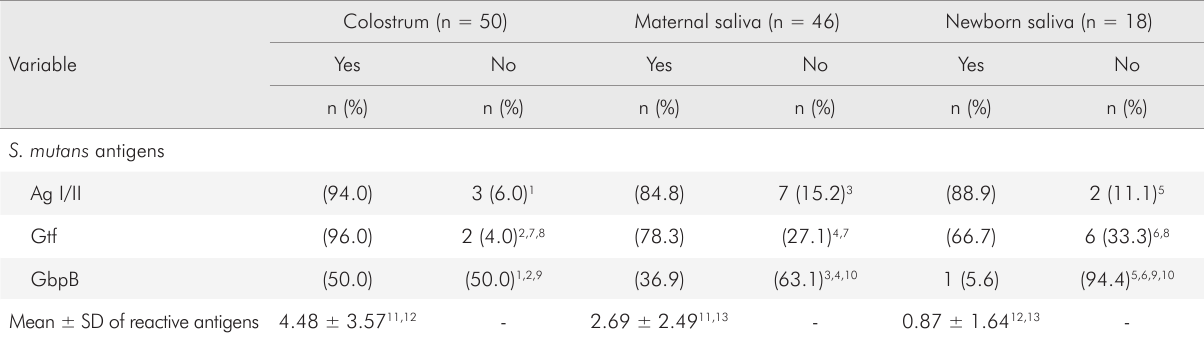
Table 1. Number and percentage of S. mutans positive samples in colostrum, maternal saliva and newborn saliva reactive or not to the S. mutans virulence antigens (Ag I/II, Gtf and GbpB). The mean and standard deviation of reactive bands in each tested group is also given.